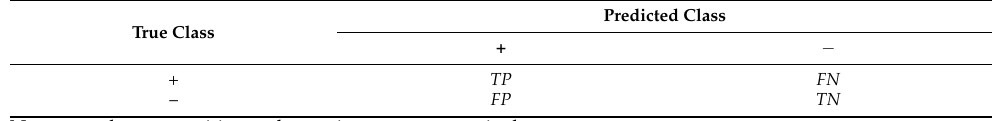
Table 9. A typical confusion matrix.